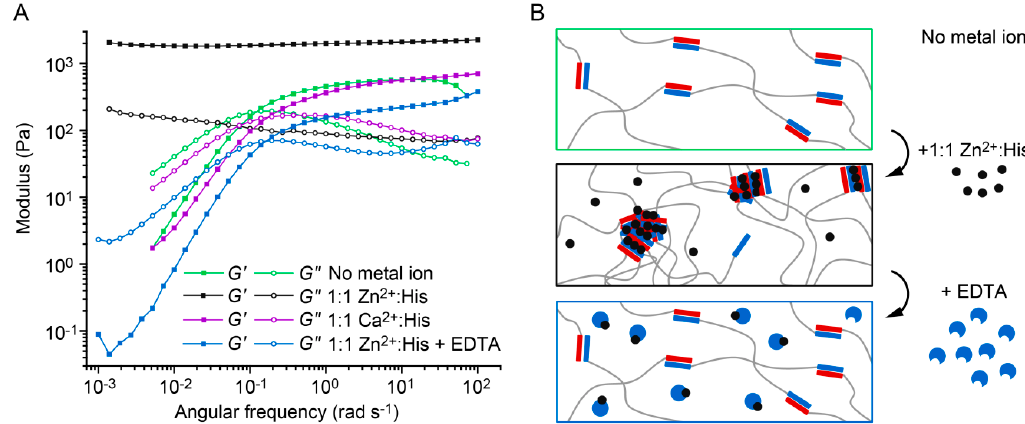
Figure 4. Frequency sweeps of A 4H3 B 4H3 -containing hydrogels in PIPPS buffer. ( A ) Frequency sweeps were performed in the absence of metal ions, in the presence of 1:1 Ca 2+ :His, 1:1 Zn 2+ :His and 1:1 Zn 2+ :His + 25 mM EDTA. The frequency sweeps were performed over a range of 100 to 0.001 rad s − 1 at a constant strain amplitude of 1%. ( B ) Schematic representation of the cross-linking mode in hydrogels without metal ions, with 1:1 Zn 2+ :His and after adding EDTA.